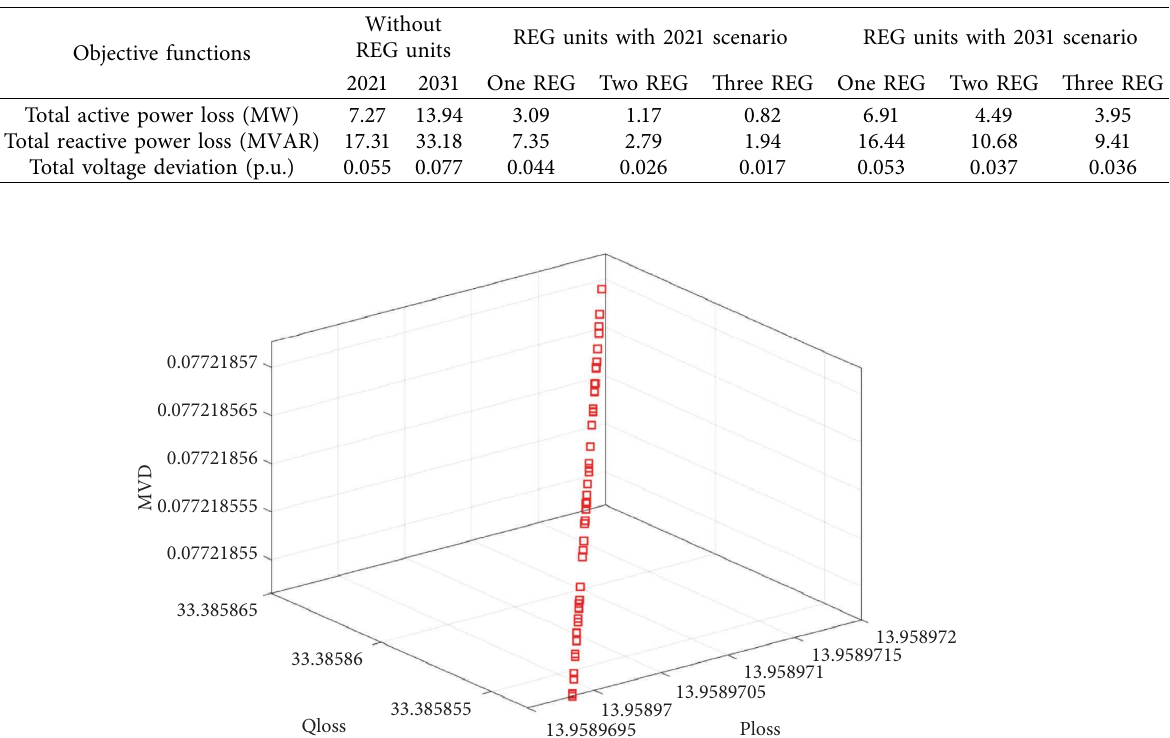
Figure 6: Objective functions in Pareto optimal solutions for the condition of year 2031 without deployment of RE